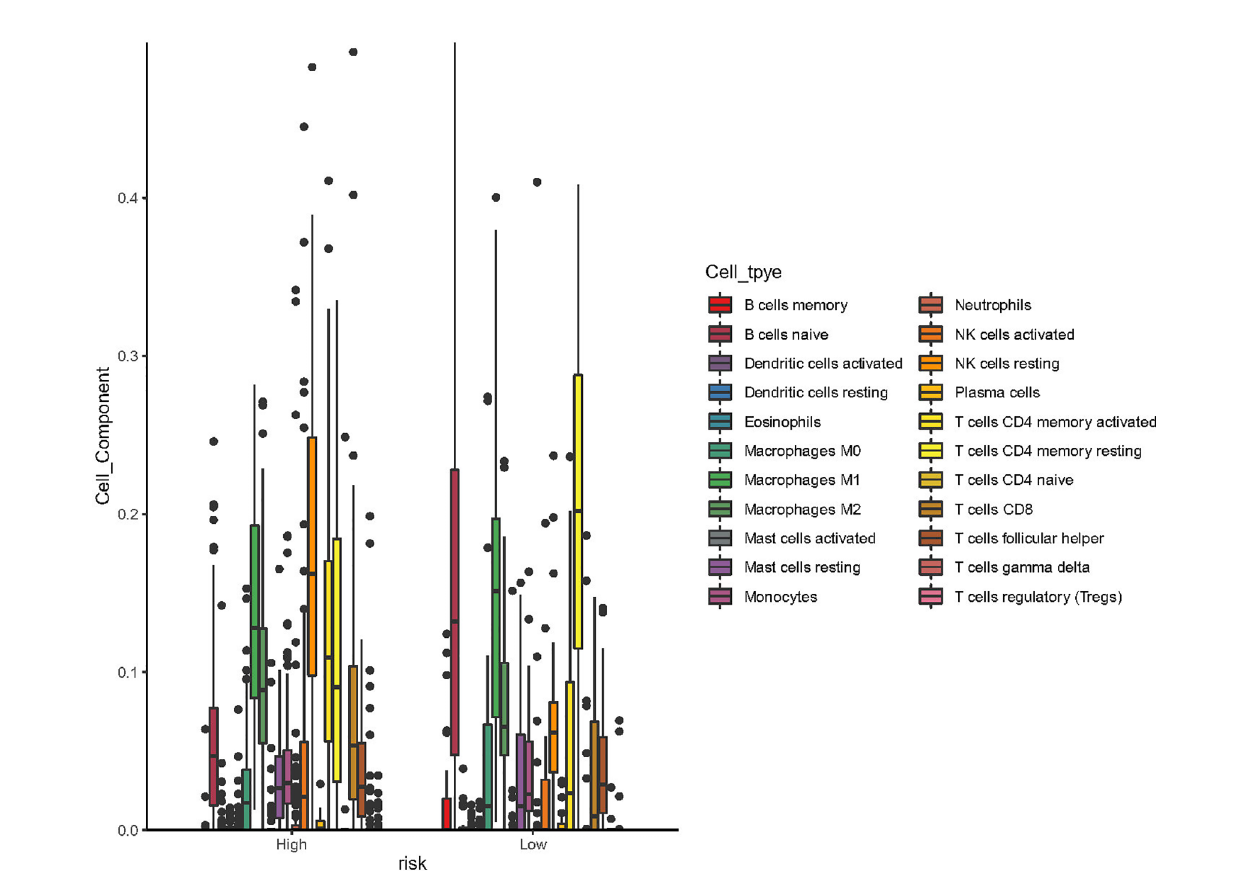
FIGURE 5 | Box plot of the processed data according to their CIBERSORT results (using ggboxplot from ggpubr R package). The fi gure showed that resting NK cells, activated NK cells, CD8 + T cells and activated CD4 + T memory cells was signi fi cantly higher in patients with high expression of